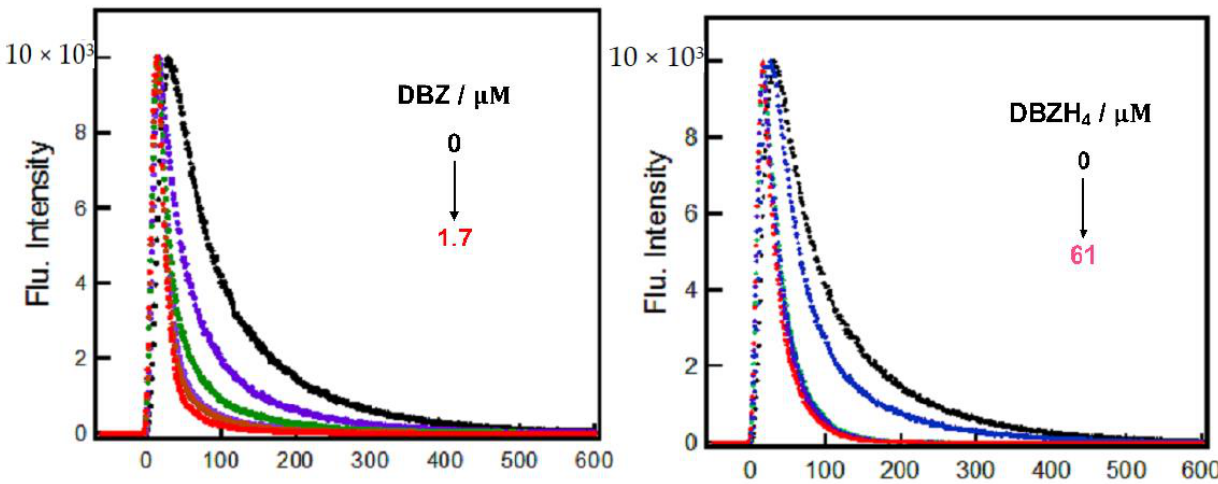
Figure 3. Fluorescence lifetime decay profile of BSA (19 µ M) in the absence and presence of zinc complexes.